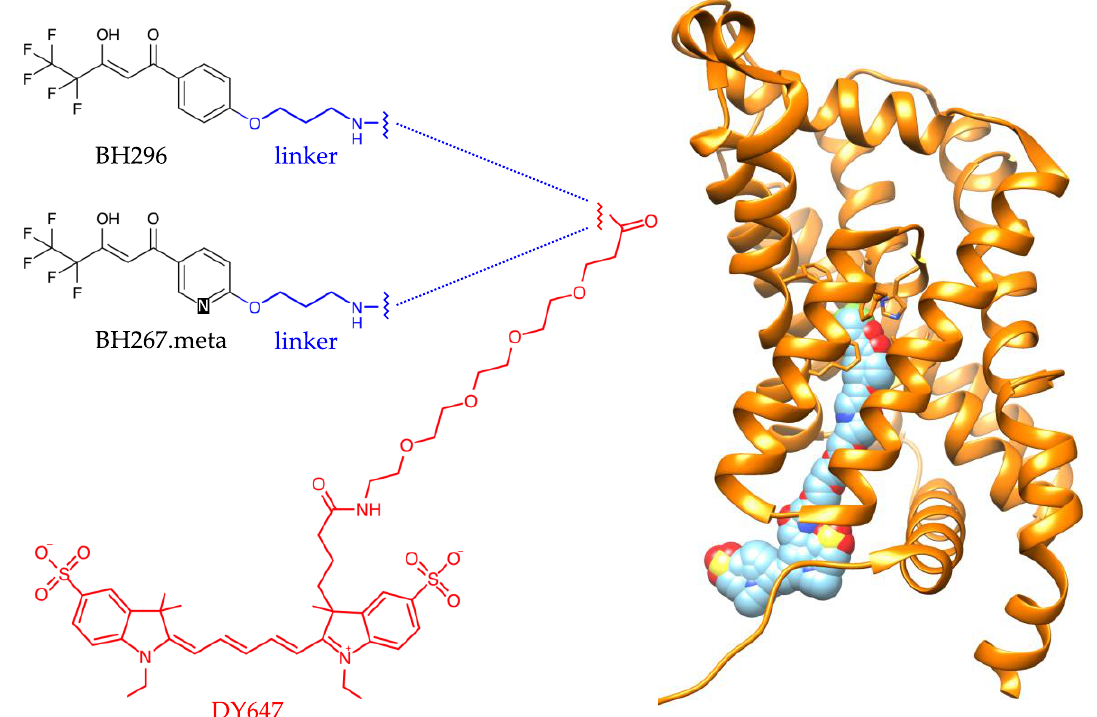
Figure 1. Inhibitors of PfFNT (BH296, BH267.meta) fused with a fluorescence label (DY647) via a 3-aminopropoxy linker. The 4 × ethylene glycol unit of the label prevents collision of the fluorescent moiety with the protein target; see model of PfFNT (PDB# 6vqr) with bound inhibitor carrying the label (right panel).